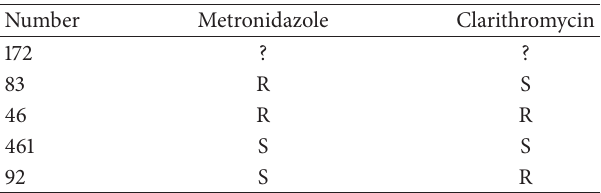
Table 2: Resistant and susceptible